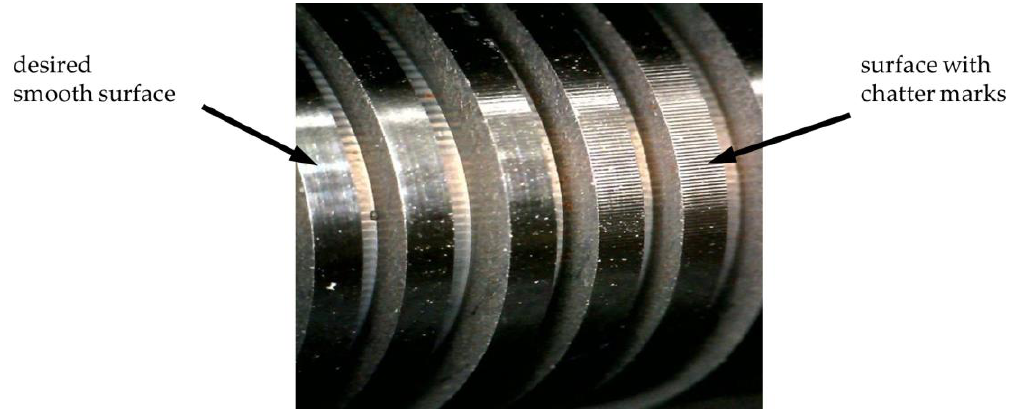
Figure 1. Undesired chatter marks in a turning process (right half of picture).